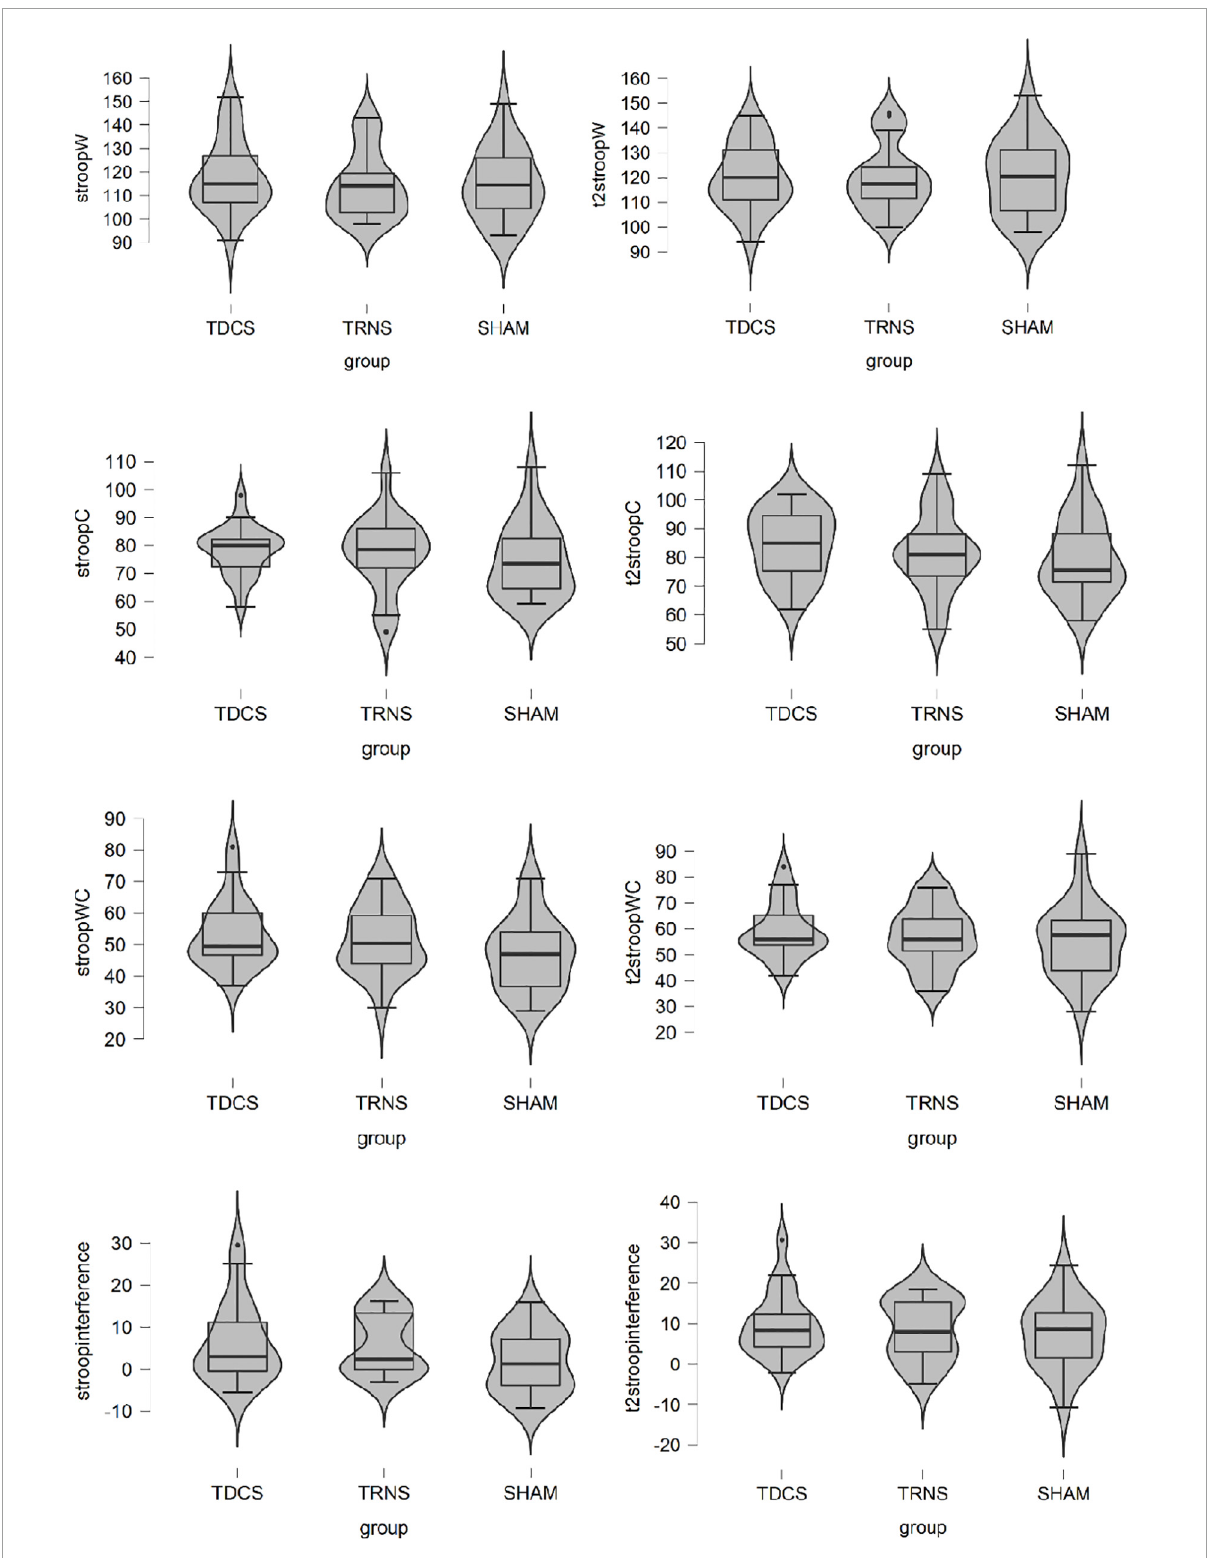
FIGURE2 Stroop scores of transcranial direct current stimulation (tDCS), transcranial random noise stimulation (tRNS), and sham group at baseline and during